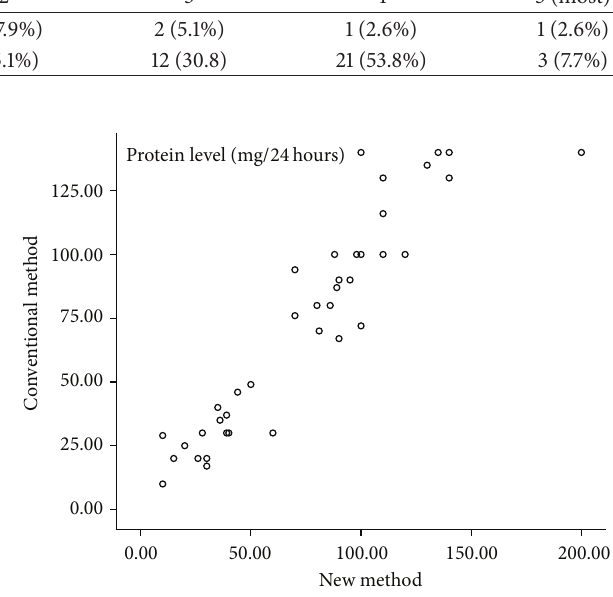
Figure 5: Conventional plot: Urine protein levels in 24 hours as measured by conventional and new methods.